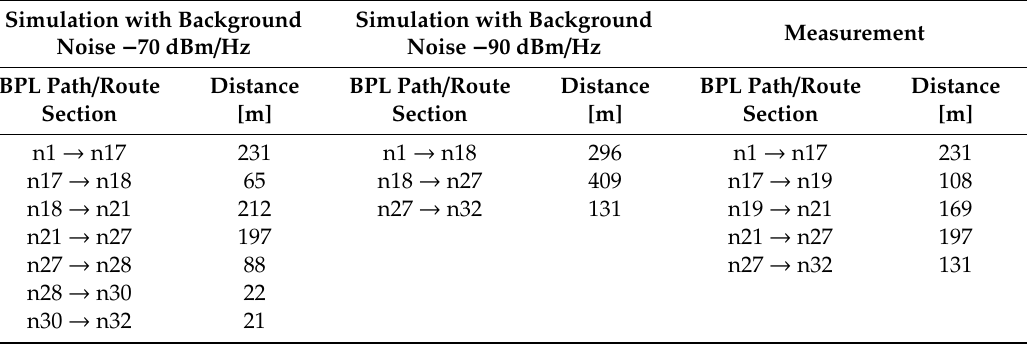
Figure 11. Comparison of simulation with measurement. Table 5. Comparison of simulation with